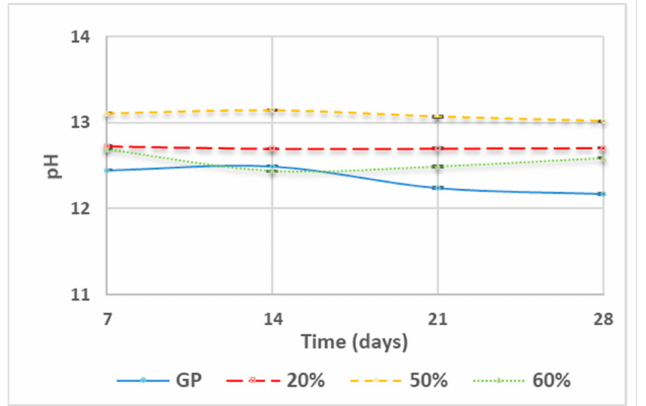
Figure 4. pH of the solution obtained immersing in water the samples of GP and GP/WG (20, 50 and 60%) at different curing times. Error associated with this measurement is approx.